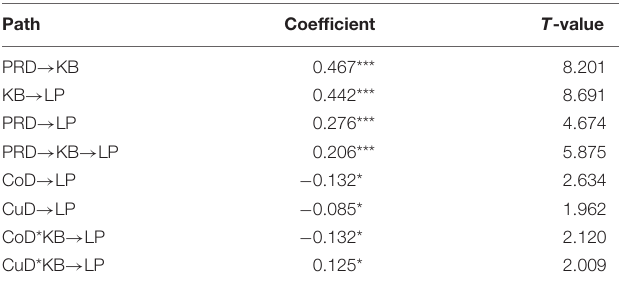
FIGURE 2 | Path analysis results of learning mechanism 1. * p < 0.05 (two-tailed); *** p < 0.01